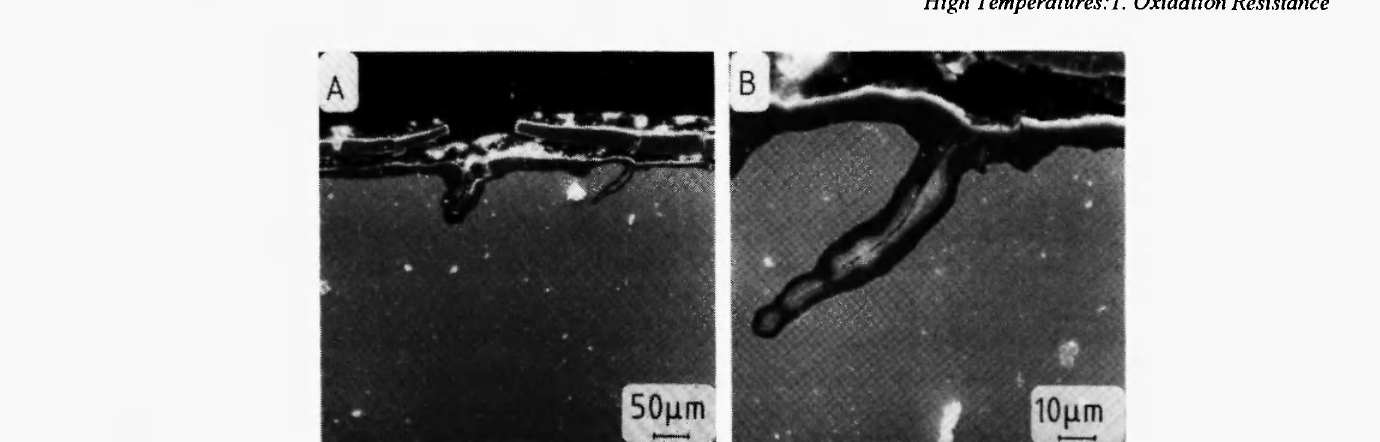
Fig. 15: Oxide protrusions into the substrate visible at polished cross-section of the alloy Fe-19Cr-5Al + 0.27Y thermally cycled at 1623 Κ for 130 1-hour cycles: brighter regions inside the protrusions are enriched in yttrium and in titanium.